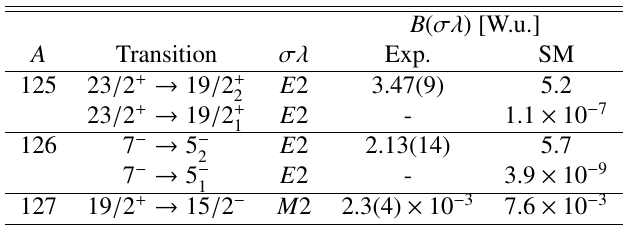
Table 1. Experimental and theoretical B ( σλ ) values for the selected transitions in A Pd